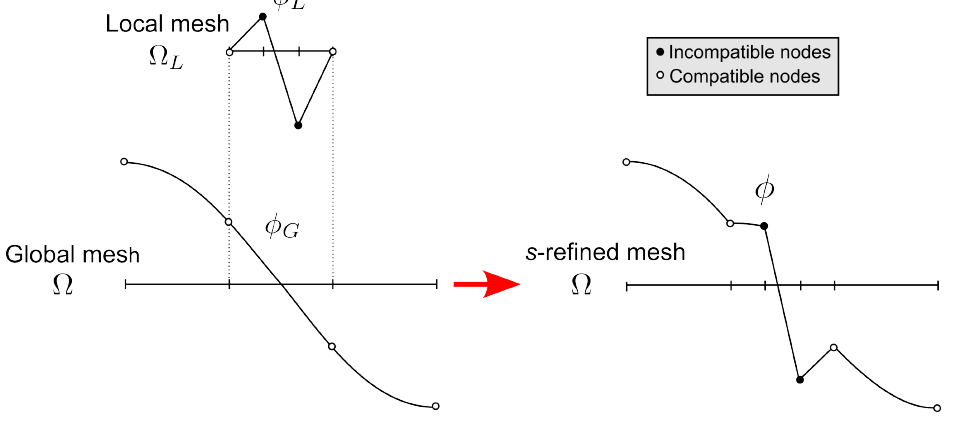
Figure 5. Conceptual idea of mesh superposition.